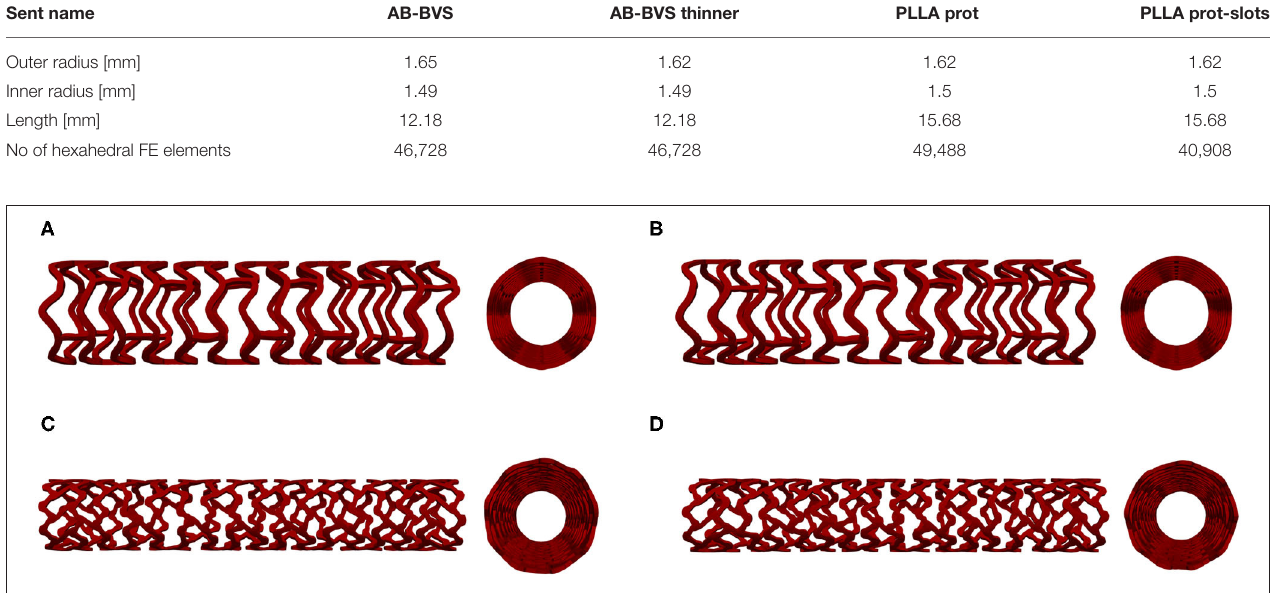
FIGURE 1 | Stent geometry: AB-BVS (A) , AB-BVS-thinner (B) , PLLA prot (C) , PLLA prot-slots (D) .